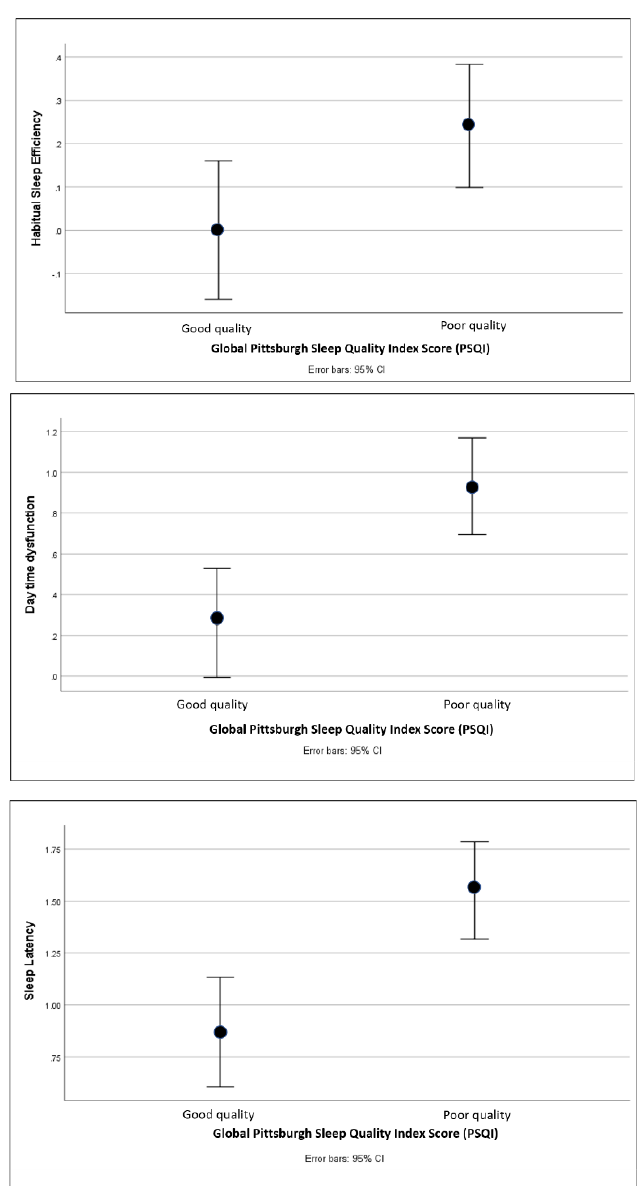
Figure 1. Differences between ‘good’ and ‘poor’ sleep quality groups based on the PSQI scale score, for sleep efficiency (top), daytime dysfunction (middle), and latency (bottom). Error bars present 95% Confidence